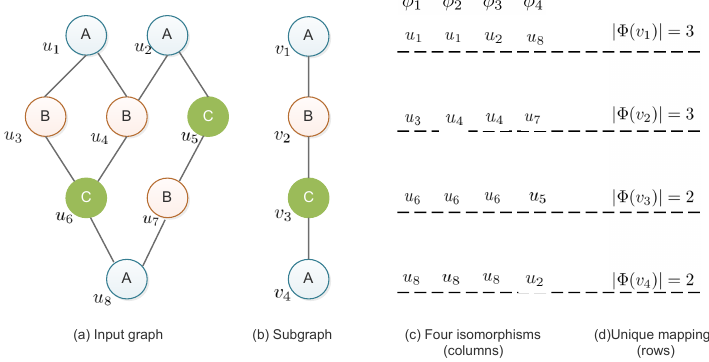
Figure 2. Minimum image (MNI) support of a subgraph G 1 ≡ A - B - C - A in a single graph G with eight vertexes and three vertex labels.